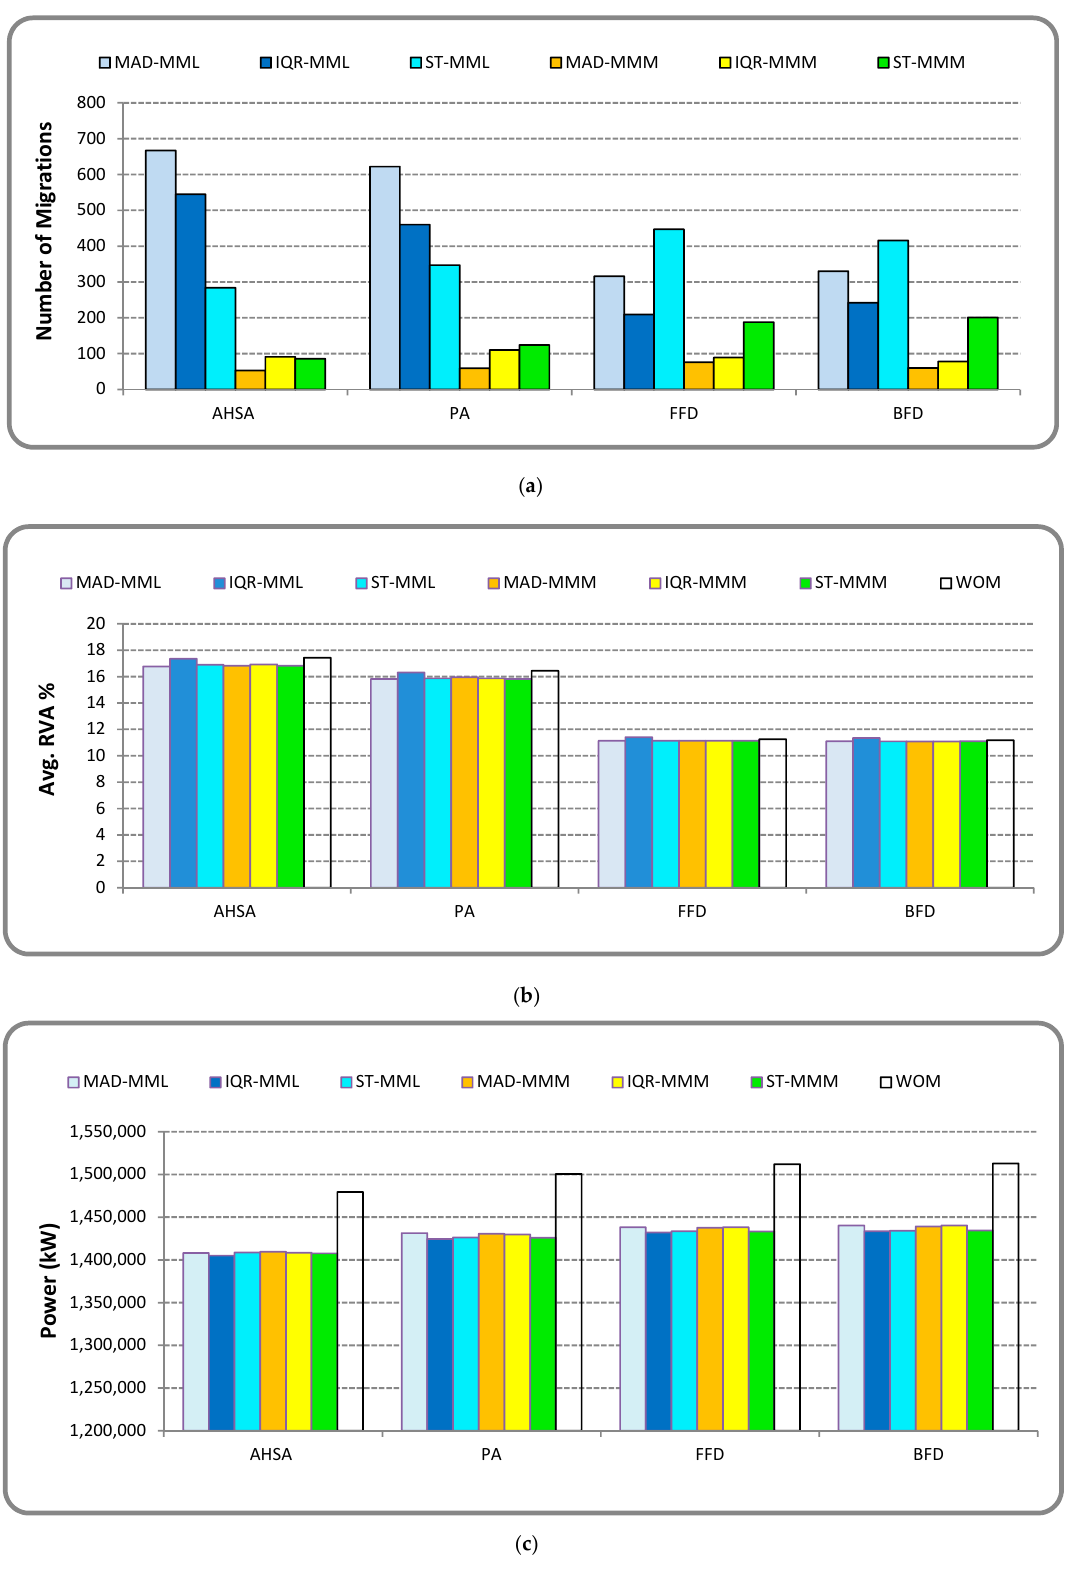
Figure 12. Impact of migration ( a ) Number of migrations ( b ) RVA% ( c ) Power consumption.